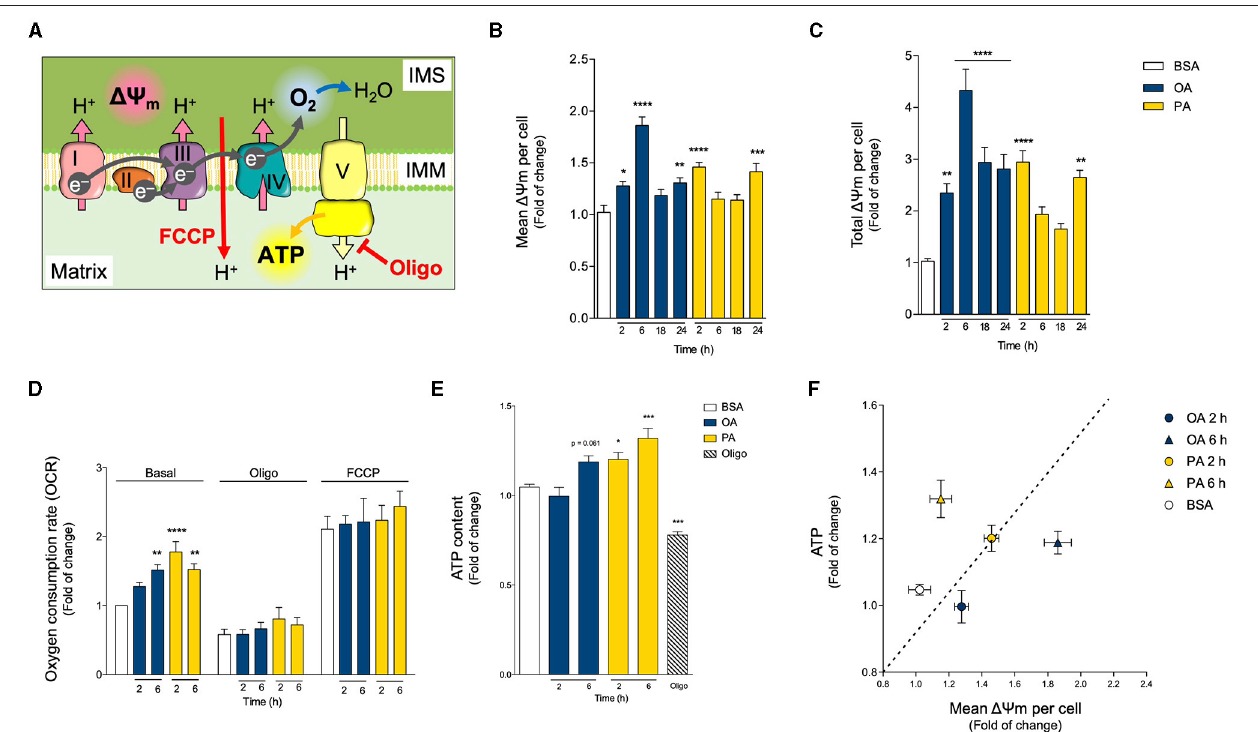
FIGURE 4 | Oleic and palmitic acids differentially modulate mitochondrial bioenergetics in HepG2 cells. (A) Schematics of mitochondrial respiration through the mitochondrial matrix and the intermembrane space (IMS). Complexes I, III and IV pump H + across the inner mitochondrial membrane (IMM), generating the mitochondrial transmembrane potential ( 19 m), and ultimately, transforming O 2 into H 2 O. Then, complex V synthesizes ATP using the proton gradient of the 19 m. Oligomycin (Oligo) inhibits Complex V, thus leading to the build-up of the 19 m, which hampers mitochondrial respiration. FCCP, on the other hand, dissipates the 19 m, thereby eliminating the electrochemical restraint on mitochondrial respiration. (B,C) Mean and whole-cell 1 ψ m of HepG2 cells treated with 200 µ M of oleic acid (OA) or palmitic acid (PA) for 0–24h, measured using MitoTracker Orange and confocal fluorescence microscopy. Data are from N = 6–20 cells analyzed from three independent experiments. (D) Oxygen consumption rate (OCR) of cells treated as in A, measured after 2 and 6h of treatment. Baseline respiration, non-ATP-associated respiration (Oligo 400 µ M), and the maximal respiratory capacity (FCCP 20 µ M) were measured sequentially for 3min ( N = 5). (E) Intracellular ATP levels of cells treated as in A , quantified after 2 and 6h of treatment. Oligo 5 µ g/mL for 3h was used as a positive experimental control ( N = 5). (F) Mitochondrial efficiency expressed as ATP levels vs. OCR at 2h of OA or PA treatments. Results are shown as mean ± SEM; * p < 0.05; ** p < 0.01; *** p < 0.001; and **** p < 0.0001 vs.